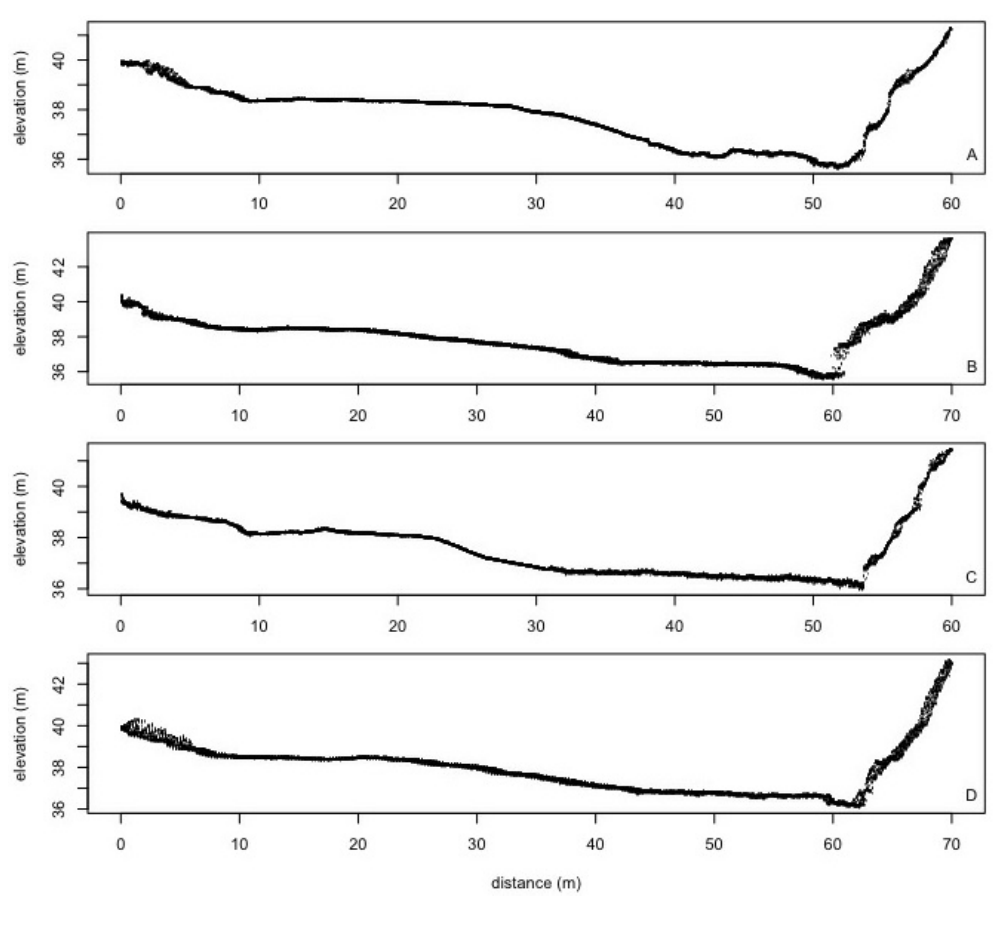
Figure 10. Transects of elevation data indicating the seamless merging of the MLS data with the bathymetry data. The location of the transects is indicated in Figure